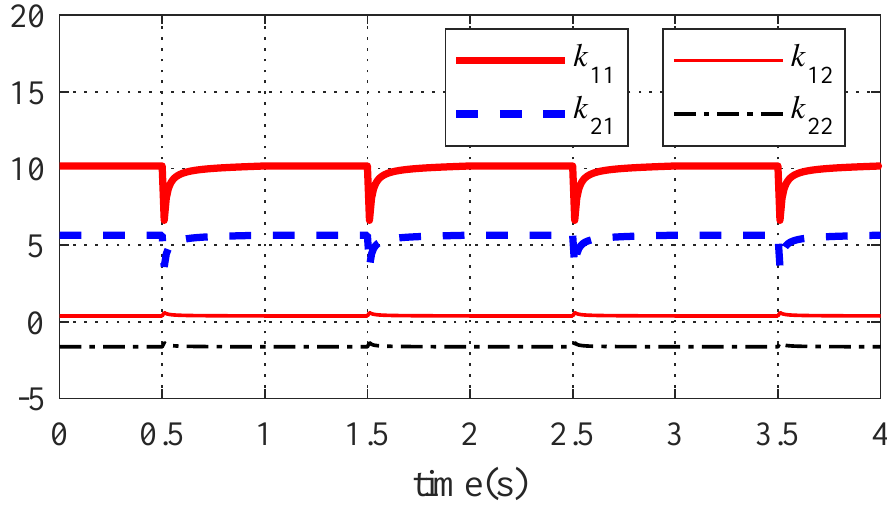
Figure 7. The elements of K 3 ( t ) .